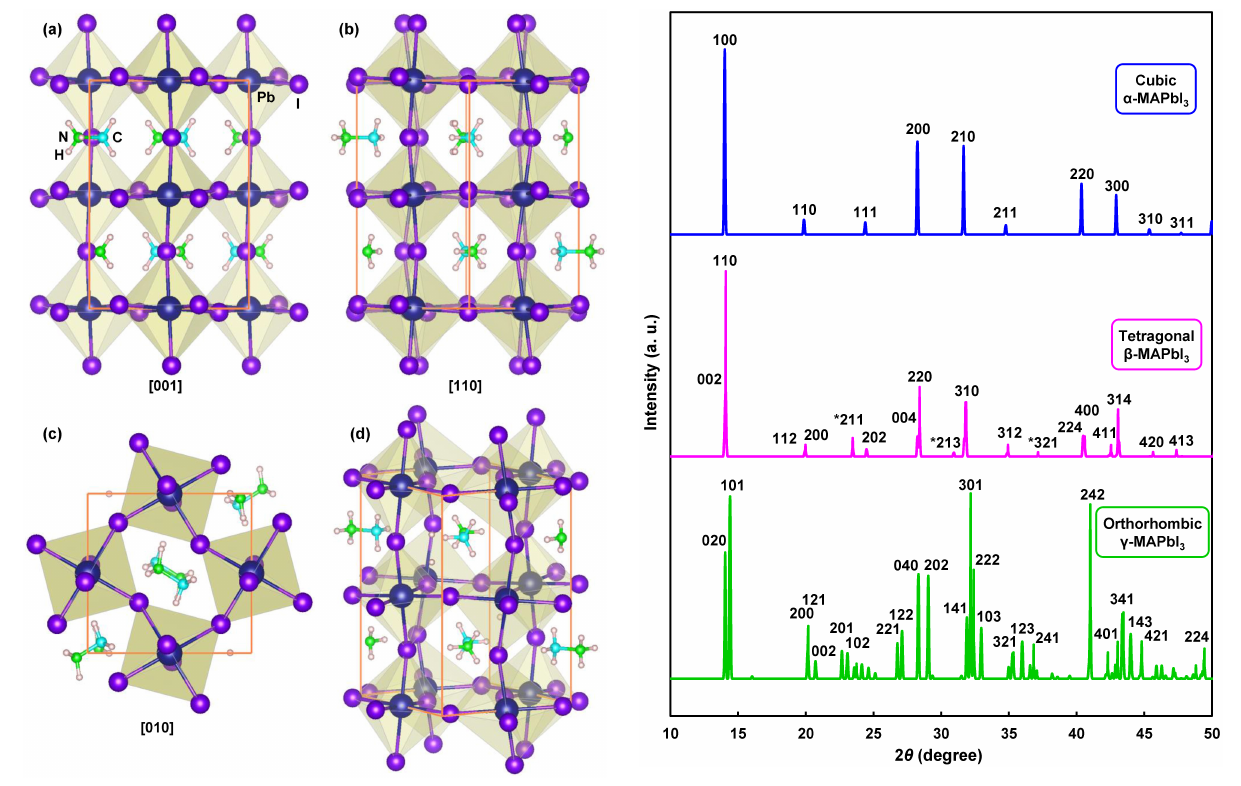
Figure 9: Structural models of orthorhombic CH 3 NH 3 PbI 3 observed along (a) [001], (b) [110], and (c) [010] directions. (d) Perspective view of the orthorhombic structure.